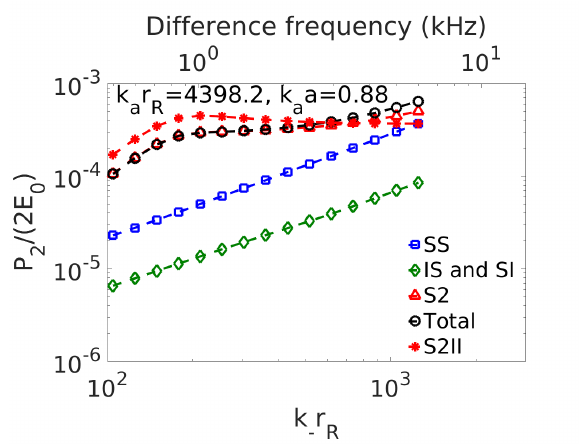
Figure 11. Equivalent to a herring at 50 m depth modeled as swimbladder with equivalent radius of roughly 1 cm with collinear incident waves of 21 kHz primary and varying difference frequencies propagating at ˆ i z using resonant bubble Equation (97) with herring damping. The difference frequency component of p 2 is calculated in backscatter at r R = − r R ˆ i z as a function of difference frequency through k − r R or k − a = k − r R k a a / k a r R . Upper abscissa shows the difference frequency for the current